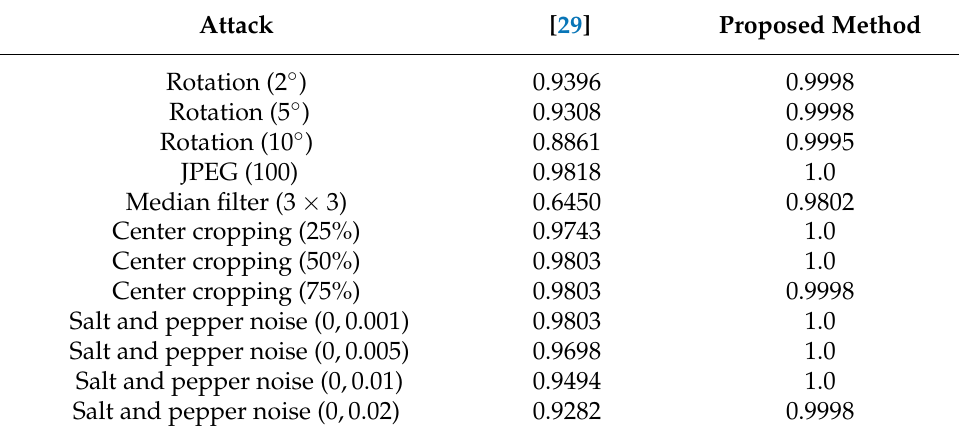
Table A2. Robustness comparison with [29] measured in terms of NC for